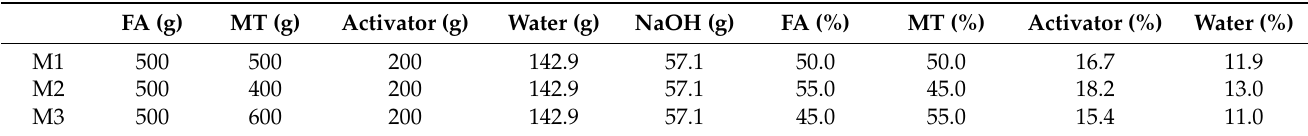
Table 5. Composition of the mixtures studied (in grams and